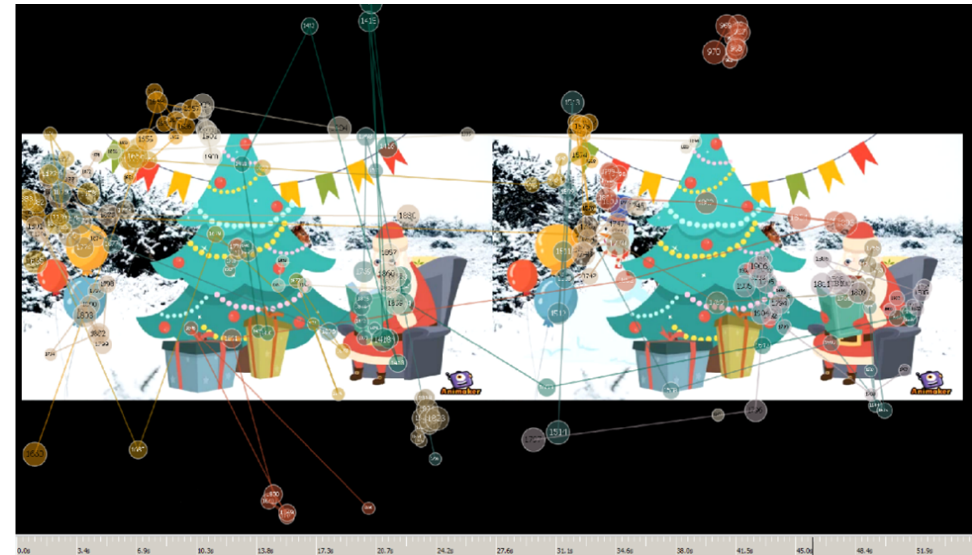
Figure 8. Scan paths with a left-to-right arrangement.